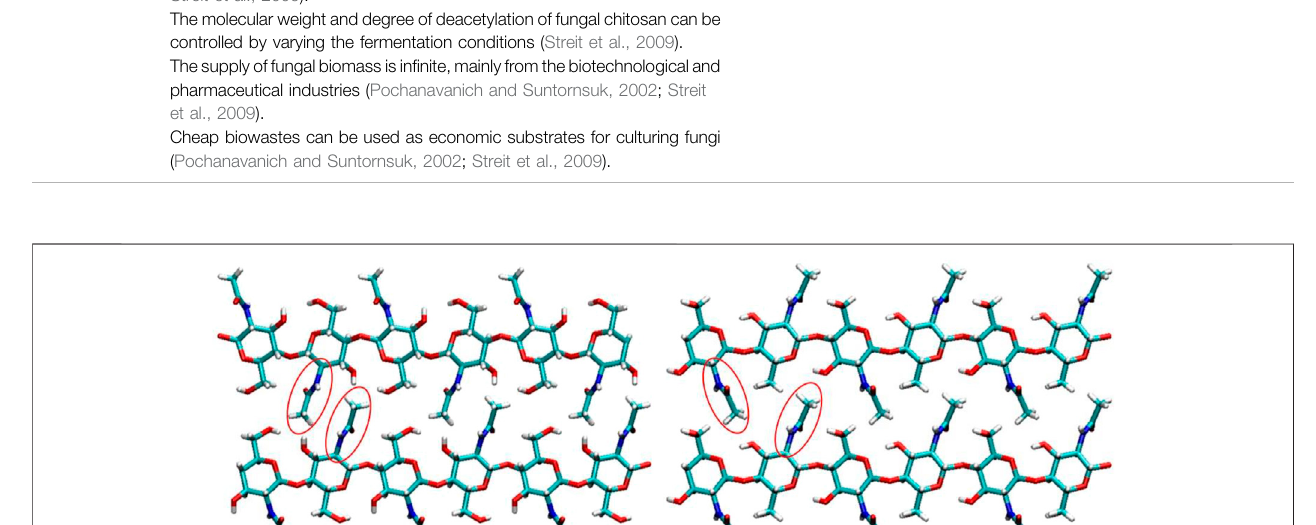
Frontiers in Materials |